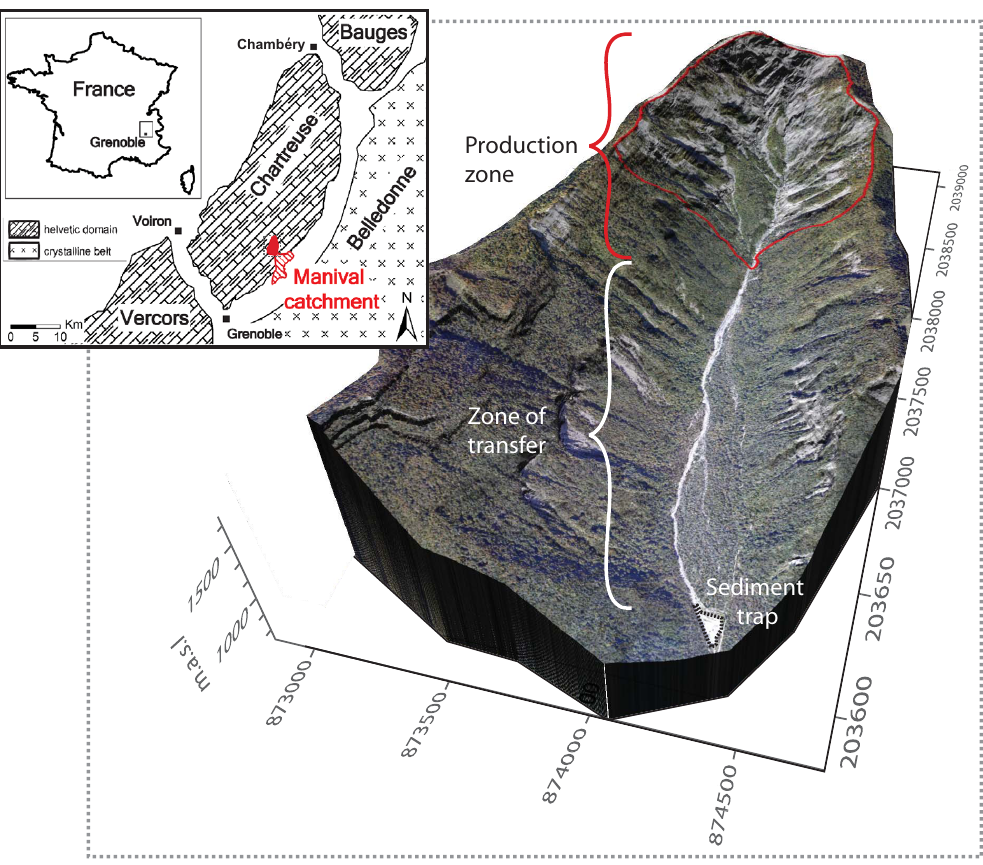
Figure 1. Inset: map of the study area; the Manival catchment is in solid red and the impressive debris fan is hatched. Main: aerial view of the Manival catchment, draped over a topographic model; sediment supply is concentrated in the headwater (production zone) as erosion activity from the middle and lower catchment is not connected to the torrent (zone of transfer) (image: Aerodata International Surveys; DEM: Irstea UR